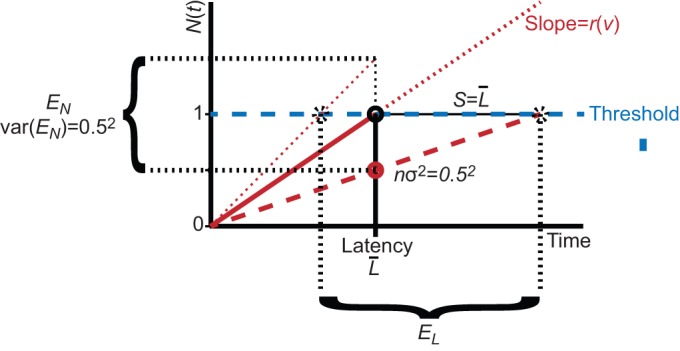
Noise estimation for the integrate and fire model. The relationship between noise in the integrator value (EN) and resulting noise in the latency (EL). As shown in the figure, per Eqn 6 for our threshold value of 1 (dashed blue line) the mean value N(t) of the integrator rises with slope r(t)=1/L as depicted by the solid red line, in order to reach an average latency L, depicted by the solid black line and circle. To result in a threshold crossing at the time T=L+S with S=L, the slope of our integrator has to be r(v)/2, shown by the dashed red line. In that case, at time L, our integrator value N(t) would be equal to 0.5 as shown by the solid red circle. Therefore, we set the s.d. of our total error EN in the integrator to 0.5. This does result in an error EL in the latency that has an s.d. S<L, which is distributed asymmetrically around the latency L, as visualized by the location of the stars.